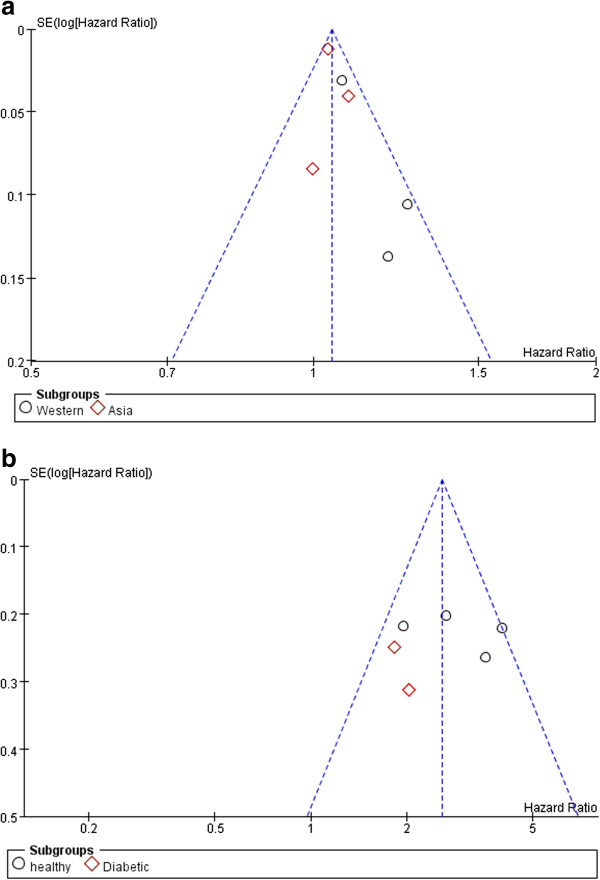
Funnel plot of association between increasing SUA or hyperuricemia and new-onset CKD. a. Funnel plot of association between increasing SUA and new-onset CKD, b. Funnel plot of association between hyperuricemia and new-onset CKD.